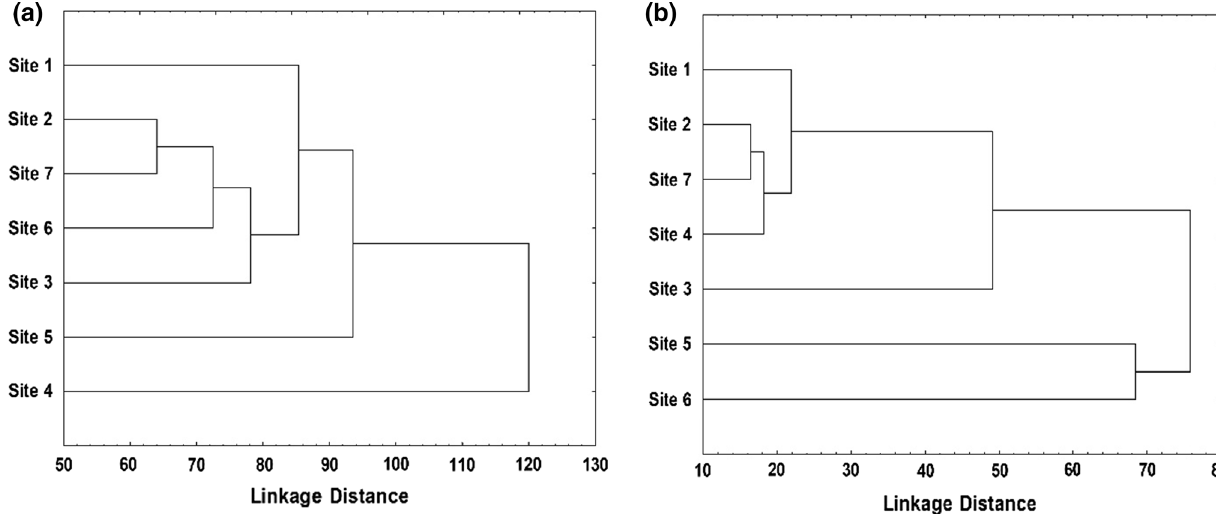
Fig. 3 Hierarchical cluster analysis (single linkage Euclidean distances) of seven different sites depending on phytoplankton assemblage ( a ) and physicochemical factors ( b